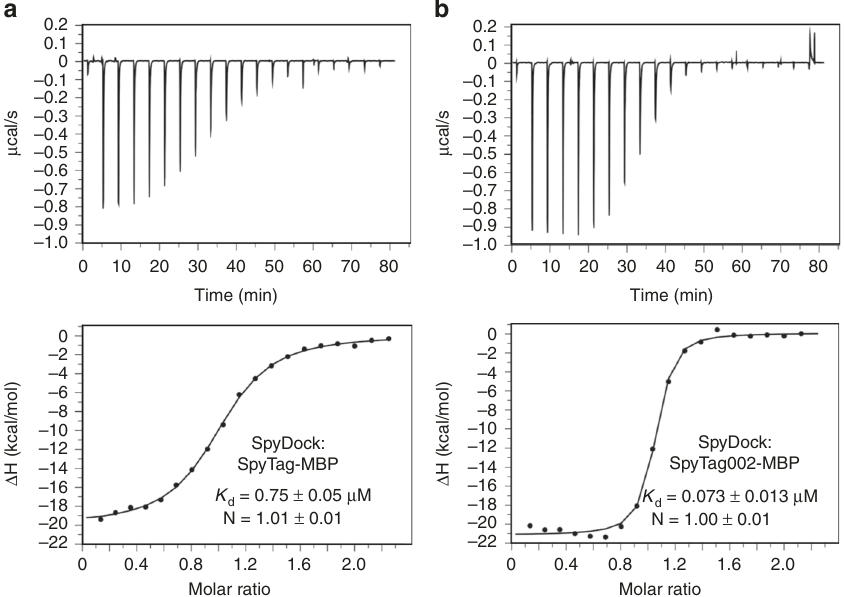
Fig. 3 Af fi nity of SpyDock for its targets. ITC binding isotherms for SpyDock binding at 25 °C to a SpyTag-MBP or b SpyTag002-MBP. Error bars represent the uncertainty in fi t to the binding curve using a 1:1 binding